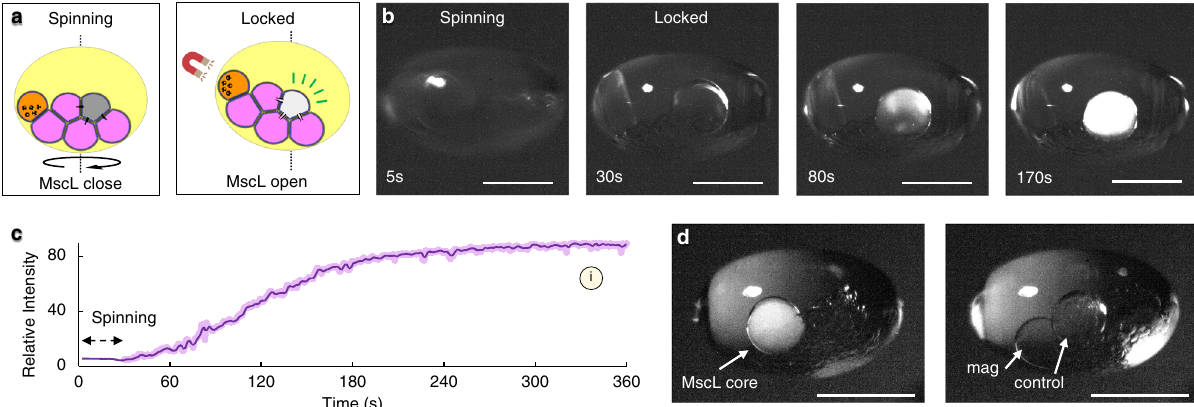
Fig. 5 Remote control of ion channel gating in levitated ACDC droplets core networks using magnetic manipulation. a Experimental concept: The incorporation of a core containing magnetic particles enables switching of the levitated arti fi cial cells with distributed cores (ACDC droplet) from a freely rotating to a locked state on the application of an external magnetic fi eld. In the free (spinning) state acoustic forces are dissipated by subtle movement. In the locked state, this is dampened and instead manifests as induction of membrane tension. This may be used to selectively activate MscL channel gating. b Time sequence images of MscL gating in a levitated ACDC droplet. From left to right; t = 5 s in the absence of an applied magnetic fi eld the ACDC droplet is allowed to spin in the acoustic trap. At t = 30 s, the magnetic fi eld is applied, locking the ACDC droplet in position. MscL is activated and Ca 2 + ion fl ux induced, observed by the fl uorescent reporter, fl uo-8, present in the MscL-containing core. At t = 80 s, signi fi cant fl uorescence increase is observed. With the fl uorescence response saturated at t = 170 s. In the absence of MscL no fl uorescence increase is observed (Fig. S13, DPhPC symmetric bilayers). c Fluorescence intensity trace of Ca 2 + fl ux through MscL channels into a fl uo-8 containing core of a locked, levitated, ACDC droplet. (Same experiment labelled (i) in Fig. 6b). (solid line = moving average). d Images of a levitated ACDC droplet with a MscL-containing core (left), a magnetic particle-containing core and a control core containing Fluo-8 only (no MscL) (right). The orientation of the droplet here is controlled by the placement of an external magnet to enable image acquisition from two angles to illustrate the three highlighted cores. Scale bars = 1